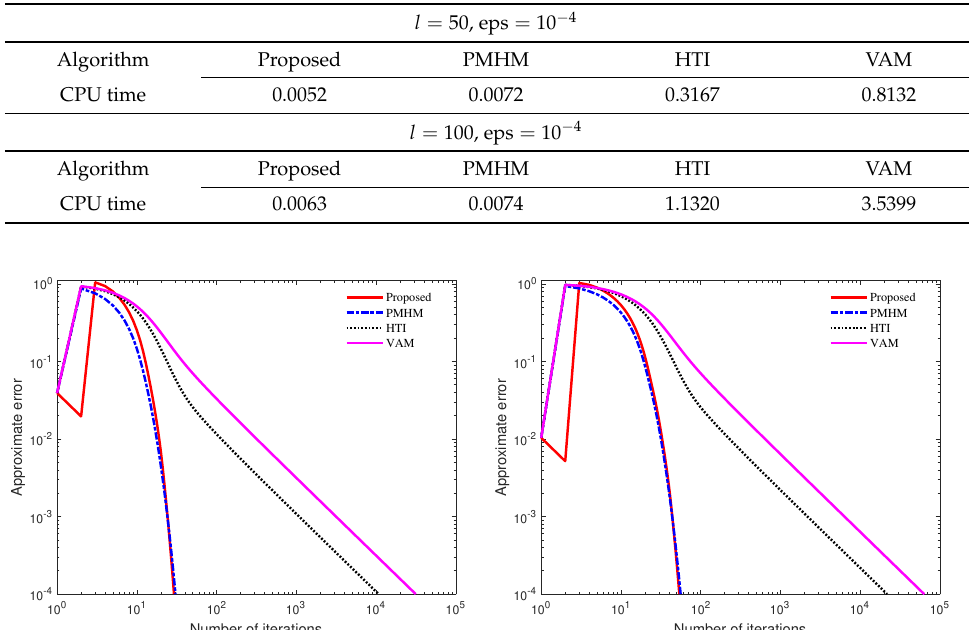
Figure 3. The progression of the CPU time for the GS, WJ, and SOR methods and the proposed methods in solving the problem (12) with l = 50 and l = 100, respectively. Table 3. The progression of the CPU time for the linear system problem.